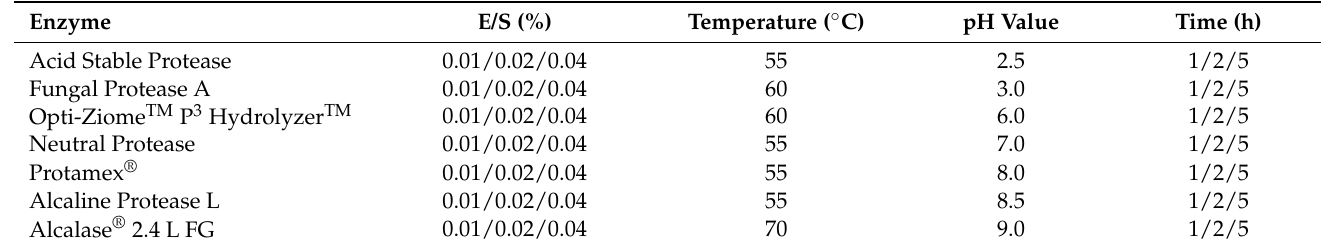
Table 2. Characteristics of the protease preparations during the LPI